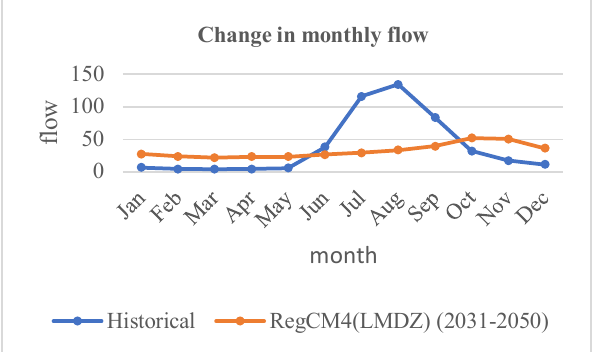
Figure 7. Flow comparison between historical and future